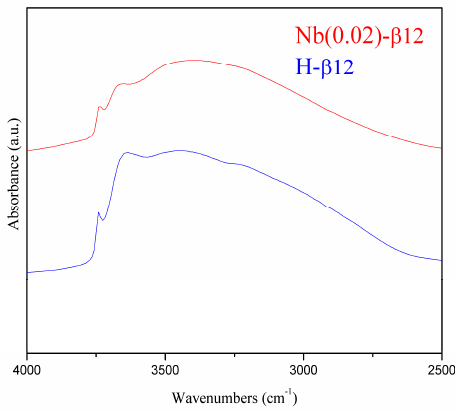
Figure 5. FTIR spectra of H- β 12 and Nb(0.02)- β 12.